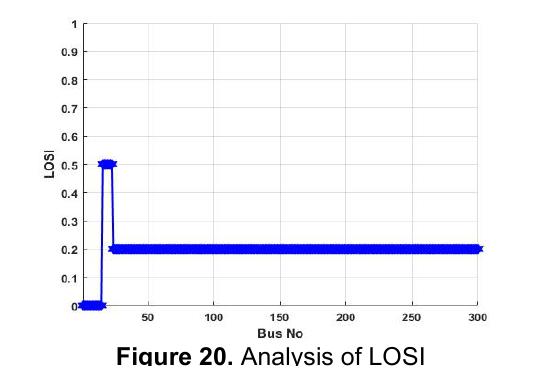
Figure 20. Analysis of